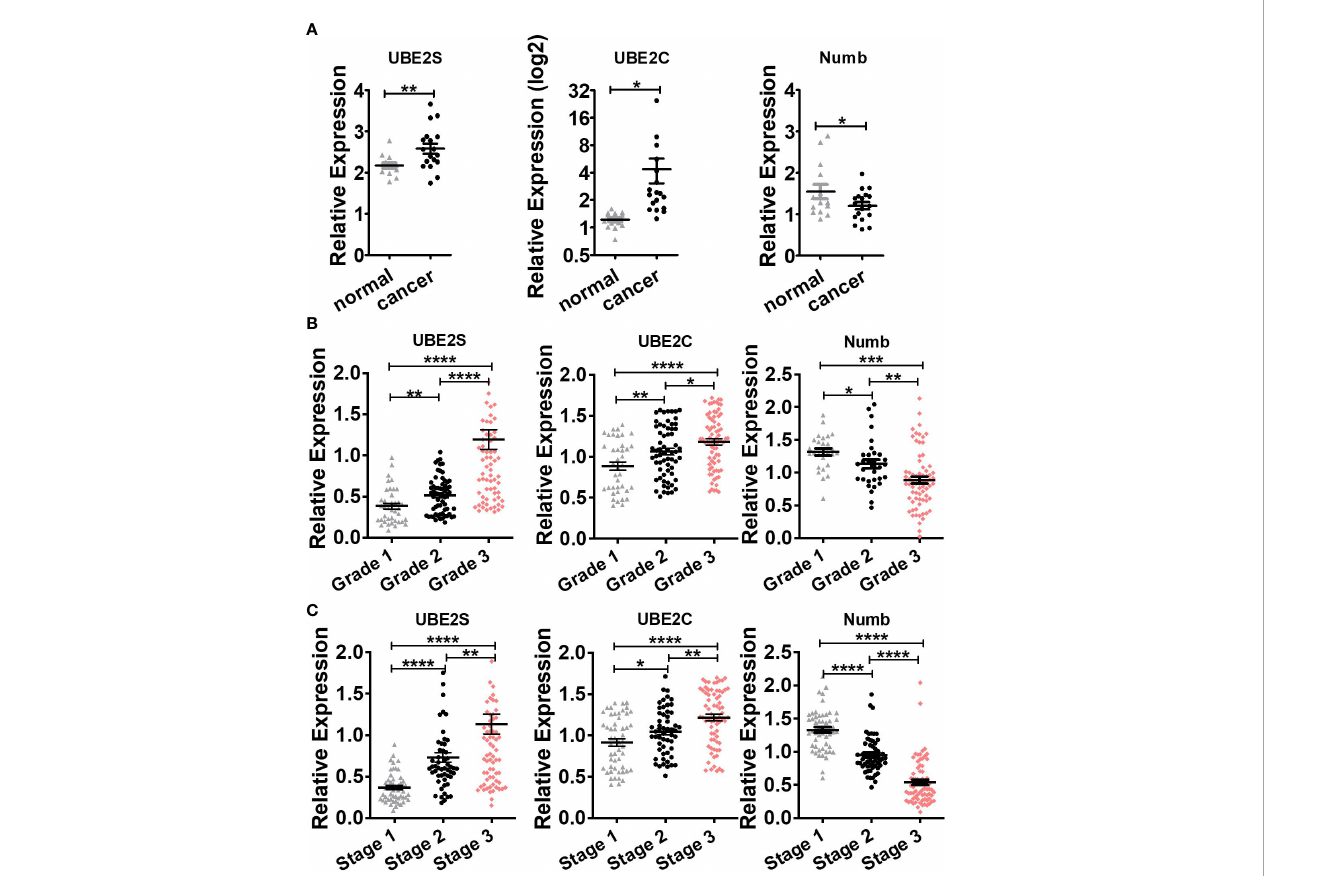
FIGURE 2 Comparison of UBE2S, UBE2C, and Numb between (A) normal breast tissues and breast tumors, as well as breast tumors of various (B) grades and (C) stages. (A) UBE2S and UBE2C are upregulated, while Numb is downregulated in breast tumors ( n = 14) compared with normal breast tissues ( n = 18) ( Oncomine database of Ma breast, 2009). normal, normal breast tissues; cancer, breast cancer tissues). (B) With the increase in breast tumor grade (grade 1 n = 39, grade 2 n = 63, grade 3 n = 76), UBE2S and UBE2C show elevated expression while Numb exhibits decreased level. (C) With the increase